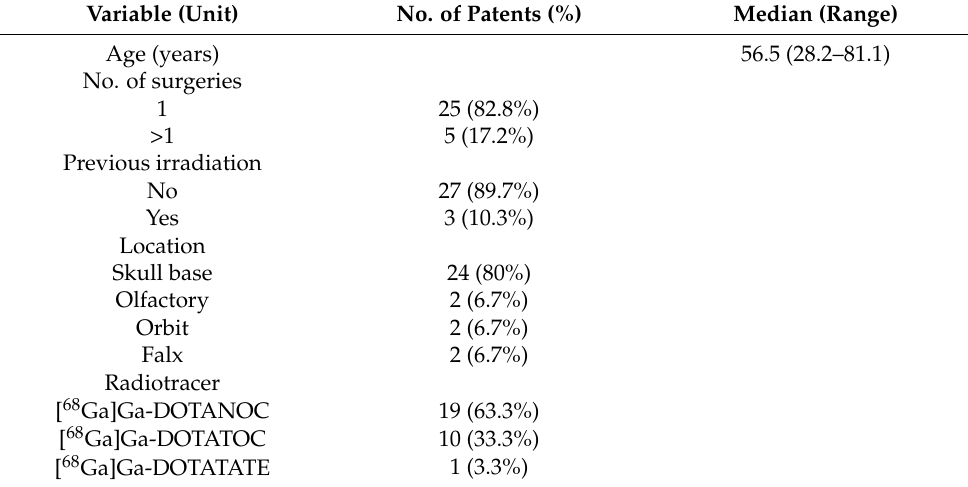
Table 1. Patient